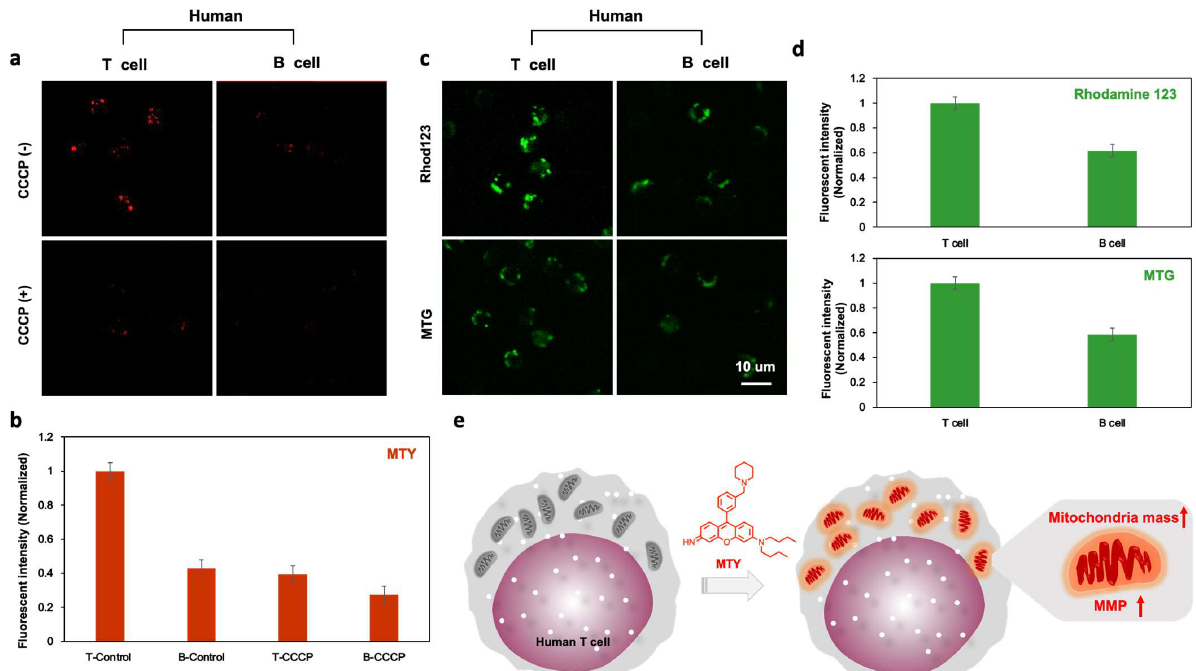
Figure 4. Mechanism for the selectivity of MTY. ( a , b ) MMP effect on the fluorescence of MTY in human T and B cells. The cells were first treated with CCCP (50 μM) for 30 min, and then MTY (100 nM) was added for 1 h. Fluorescent intensity evaluated by flow cytometry was normalized and represented as histogram. ( c , d ) The fluorescence of MTG (200 uM) and Rhod123 (100 uM) in human T and B cells. The fluorescence images were taken after 30 min incubation of MTG and Rhod123. Fluorescent intensity evaluated by flow cytometry was normalized and represented as histogram. ( e ) The proposed staining mechanism of